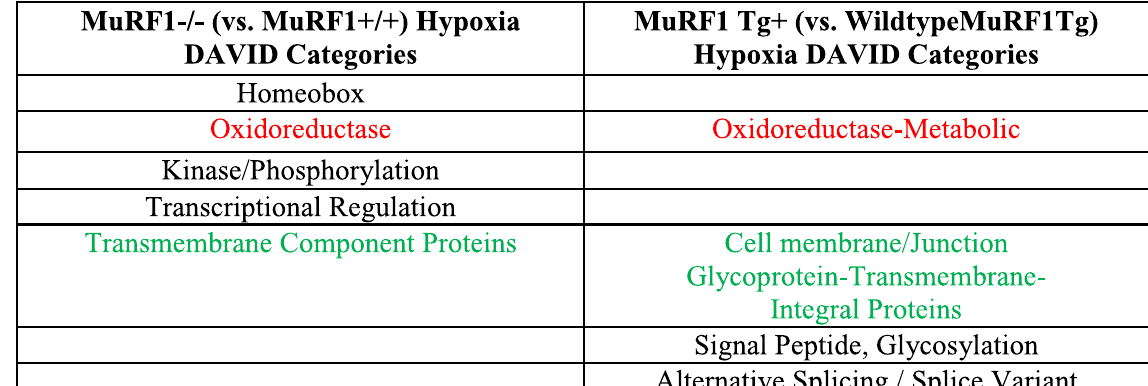
Table 1 Summary of DAVID functional annotation categories of significant genes. From Figure 3A (MuRF1-/-) and Figure 5A (MuRF1 Tg+) based off differentially expressed genes in Figure 2A and Figure 5A. Matching colors represent related categories found in hearts lacking MuRF1 and hearts with increased cardiomyocyte MuRF1 post-hypoxia challenge compared to wildtype